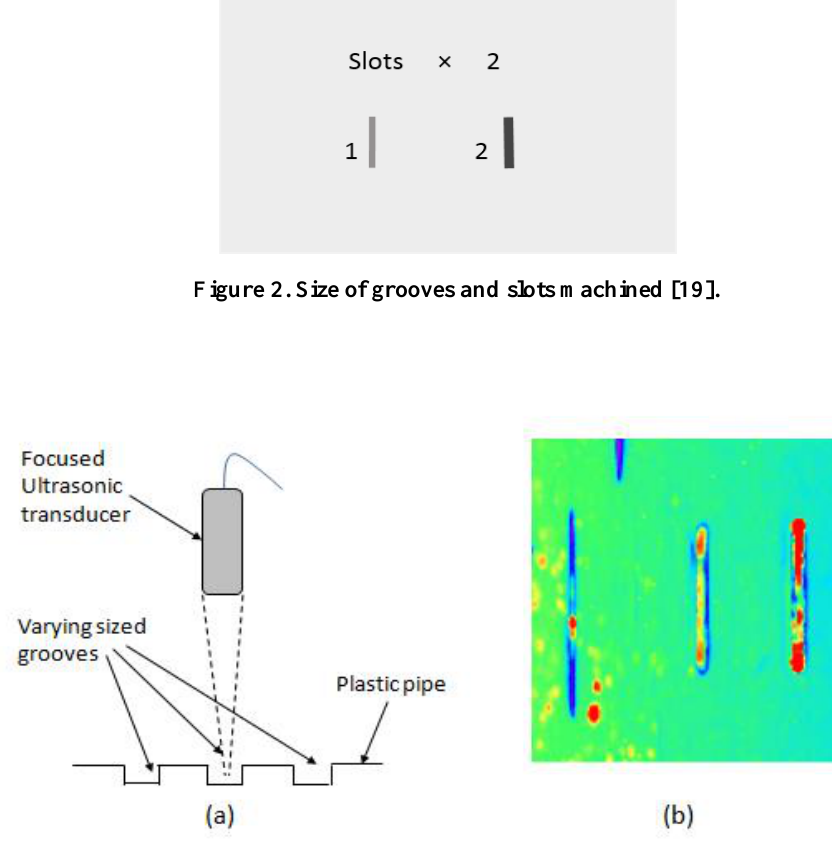
Figure 3(a). Ultrasonic testing sketch (b) detection result